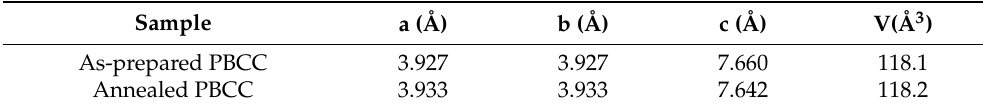
Table 1. Lattice constants measured for the thin films of the as-prepared PBCC and the PBCC after annealing under O 2 at 700 ◦